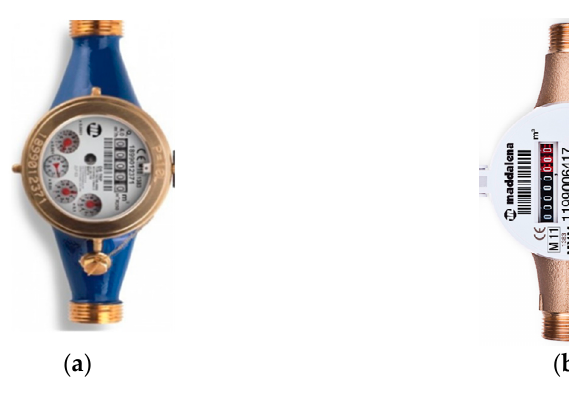
Figure 4. The water meters employed: on the left the multijet, on the right, the volumetric. Table 2. Hydraulic performance of water meters.